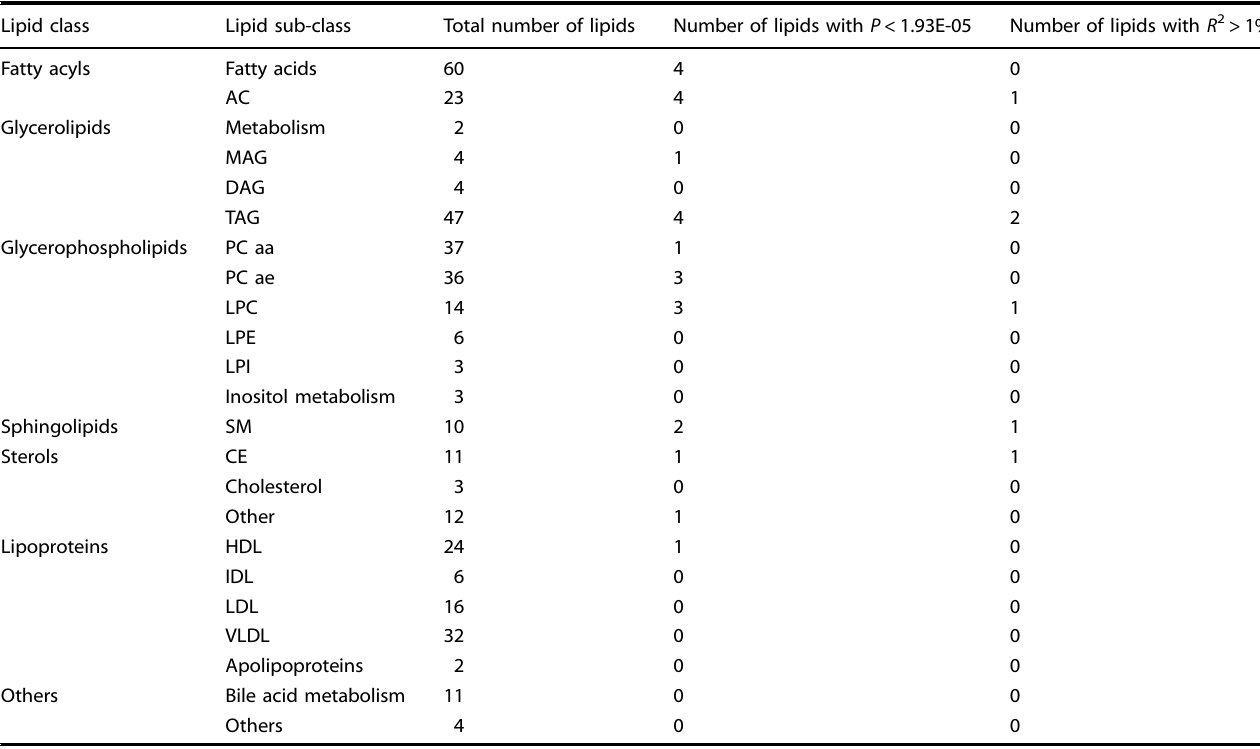
Table 1. Summary of the results of the phase I PRS-based analyses of the genetic sharing between PD and the blood levels of 370 lipids and lipid- related molecules. Lipid